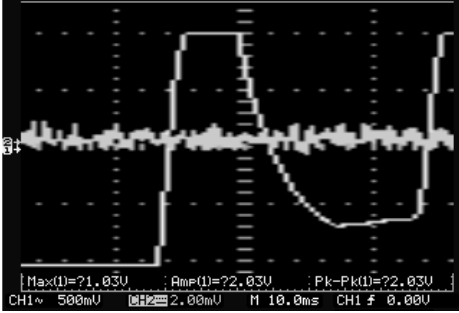
Figure 5. Time course of high voltage impulse.